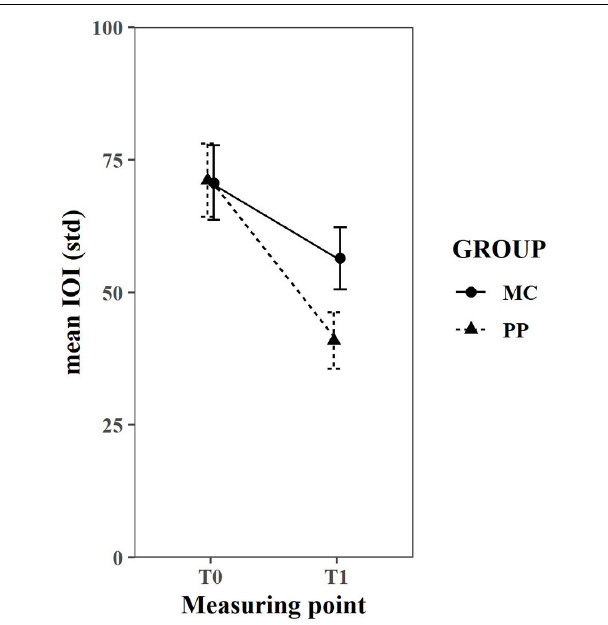
FIGURE 5 | MIDI-based Scale Analysis results. A repeated measures ANOVA revealed a significant time and time*group effect, but no main effect of group. Error bars depict the standard error. T0, baseline measurement; T1, 6 months measurement; IOI, inter-onset interval; MC, music listening/musical culture group; PP, piano practice group, std, standard